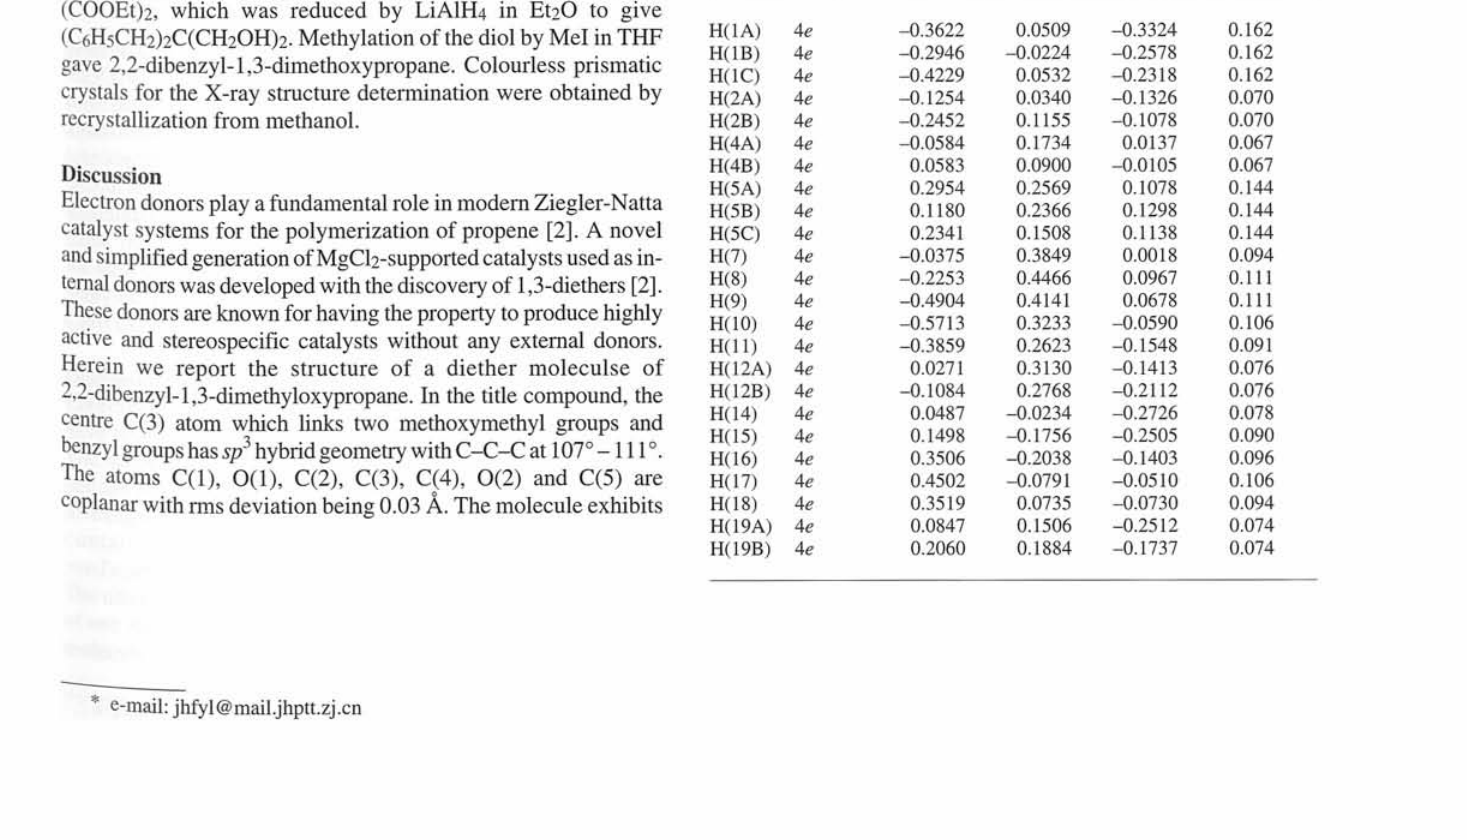
Table 2. Atomic coordinates and displacement parameters (in